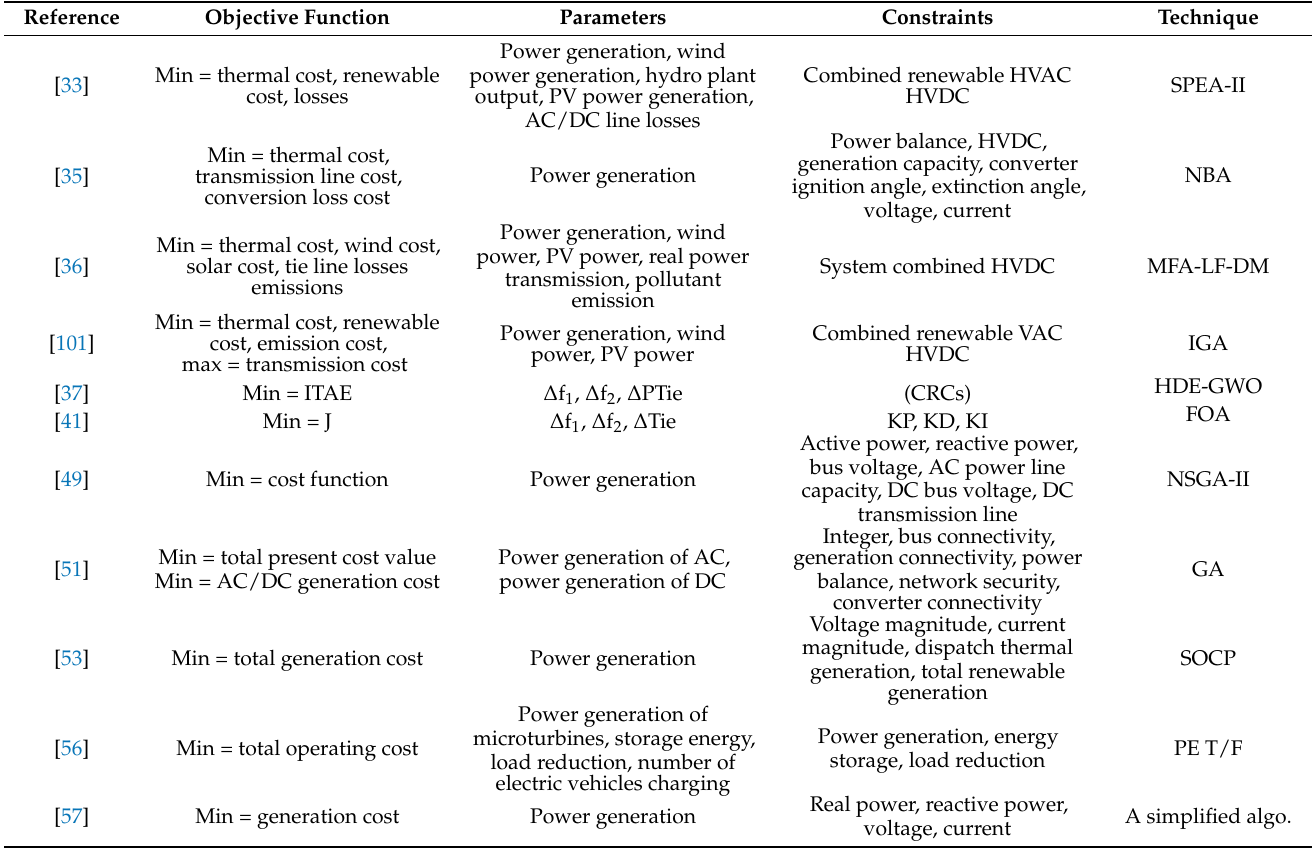
Table 5. Comparison of optimization constraints and